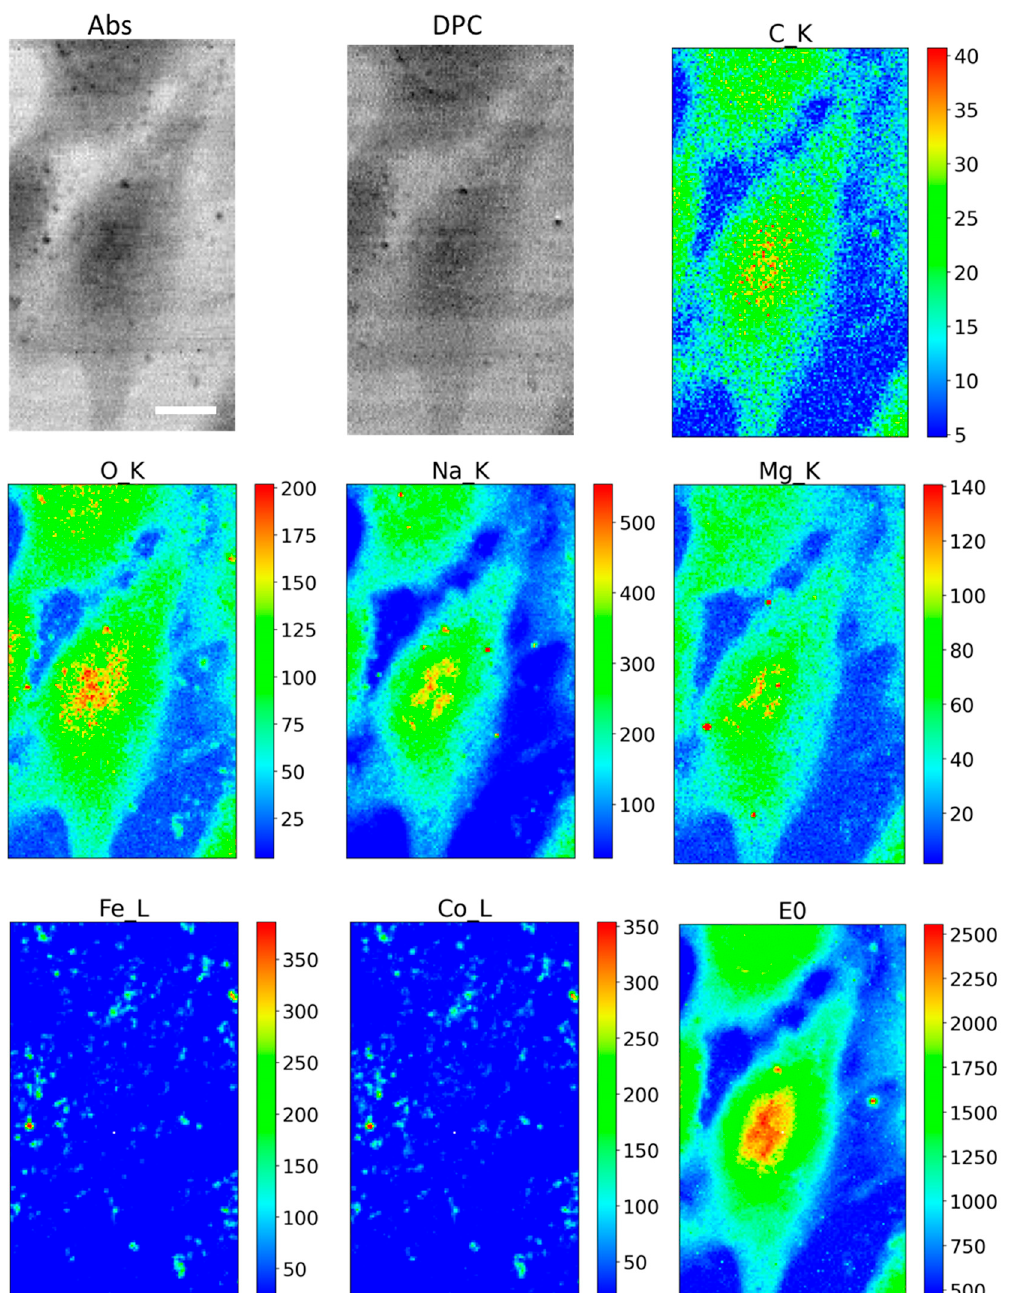
Figure 5. Absorption (Abs) and differential phase contrast (DPC) images of mouse fibroblast cells cultured on Si3N4 membranes and exposed to a 500 µM concentration of CoFe2O4 NPs, depicted with the corresponding XRF maps of C, O, Na, Mg, Fe, Co, and Scattering (E0). The maps were collected at 1.5 keV over an area of 40 µm × 70 µm with a 400 nm step size, with a 4 s/pixel acquisition time for XRF. Scale bar is 10 µm.